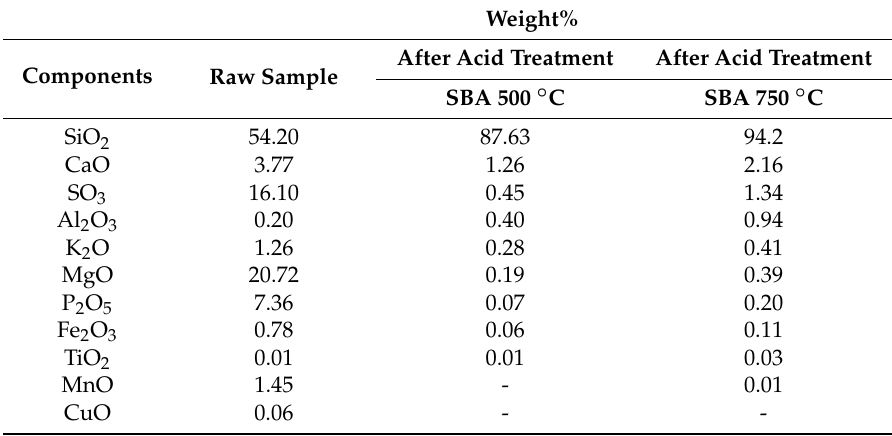
Table 1. Elemental composition of raw sugarcane bagasse ash (SBA), acid treated SBA-500 ◦ C and acid treated SBA-750 ◦